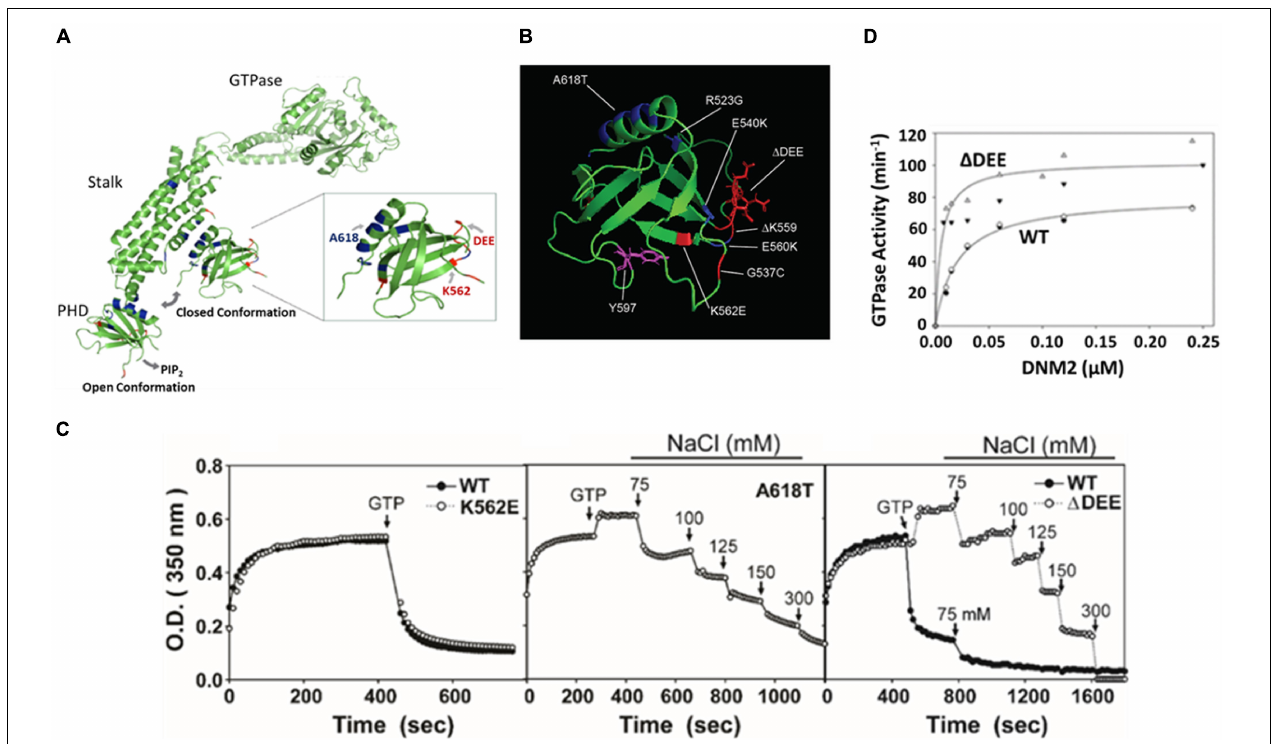
FIGURE 2 | The (cid:49) DEE mutation stabilizes DNM polymers and enhances assemb ly-dependent GTPase activation. (A) Illustration of different placements of PHD in extended and closed dynamin conformations. The sites of the mutations examined in this study are highlighted. K562E and deletion of DEE are CMT-linked mutations. A618T is a CNM-linked mutation (modified from Dynamin 1 tetrameric cryoEM structure, PDB ID: 6DLV (Kong et al., 2018). Note that the PRD was removed for crystallographic analyses . (B) Location of CMT-linked mutations (red) and CNM-linked mutations (blue) in the DNM2 PHD. Tyrosine 597, phosphorylatable by Src kinase, is shown in purple (modified from DNM2 PHD, PDB ID:2ys1 (Li et al., 2008). (C) Stabilization of dynamin 2 (cid:49) DEE mutant DNM2 polymers. Solutions containing DNM2 WT , CNM-linked mutant DNM2 A618T or CMT-linked mutants DNM2 (cid:49) DEE and DNM2 K562E at a final concentration of 1 µ M were induced to polymerize by reduction of NaCl concentration from 300 to 50 mM. After reaching plateaus, GTP and MgCl 2 were added to final concentrations of 1 and 2 mM, respectively. Arrows indicate addition of GTP and MgCl 2 or of NaCl to achieve designated final concentrations. (D) GTPase activation of DNM2 WT and DNM2 (cid:49) DEE as a function of dynamin concentration. Open and filled triangles represent data obtained from two separate preparations of DNM (cid:49) DEE . Open diamonds and filled circles represent data obtained from two separate preparations of DNM2 WT